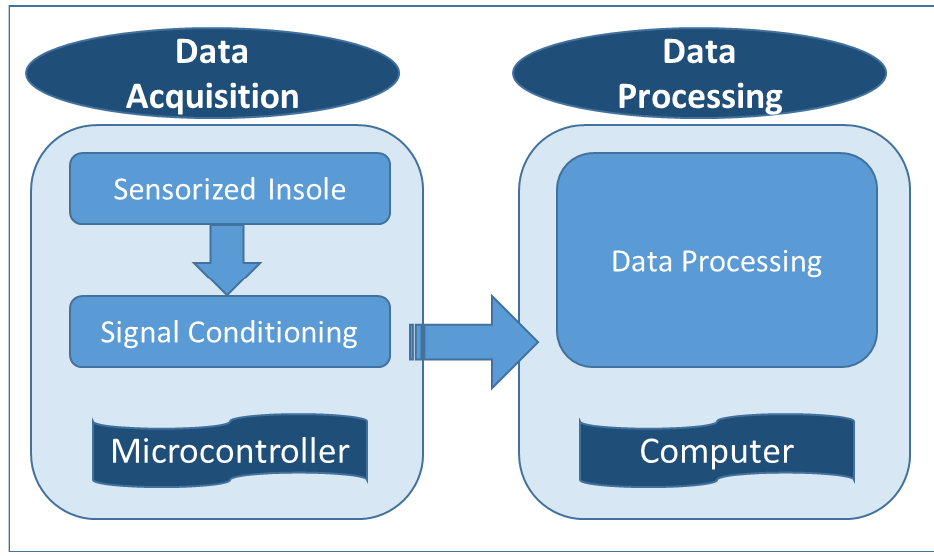
Figure 1. The block diagram of the Gait Cycle Monitoring System.